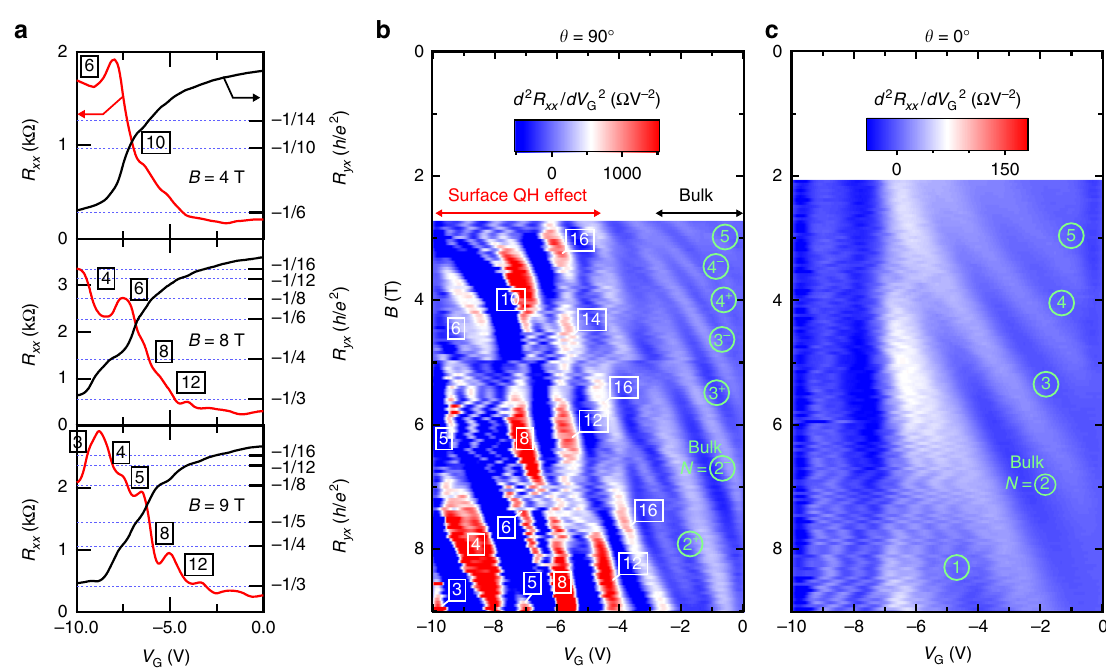
Fig. 4 Gate-modulation of the surface quantum Hall state. a Gate-voltage V G scans of transverse magnetoresistance (MR) at representative fi elds ( B = 4, 8, and 9 T) for a x = 0.19 sample with t = 95 nm. Application of a negative bias ( V G < 0) corresponds to the depletion of electrons in the fi lm. With negatively increasing V G , Surface QH states develop with quantization in Hall resistance R yx (right axis). b , c Contour mapping of the second derivative of transverse MR and longitudinal MR plotted as a function of V G and B . In the transverse MR, the surface QH effect starts to dominate the bulk conduction with reducing the electron density, while only the bulk Landau levels are observed in the longitudinal MR. The QH states are initially characterized by a degeneracy of 4, which is reduced to 2 and fi nally to 1 with increasing V G (<0) and/or